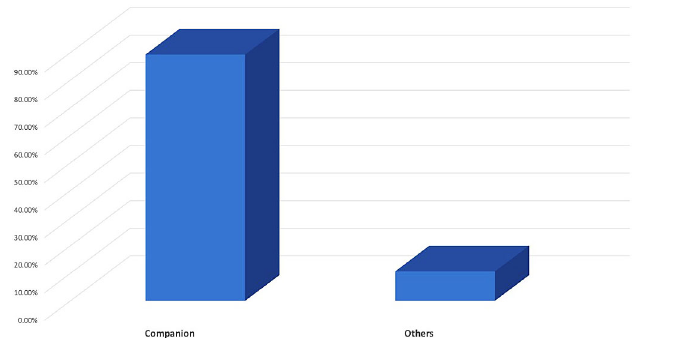
Figure 2. Purpose of having pets.